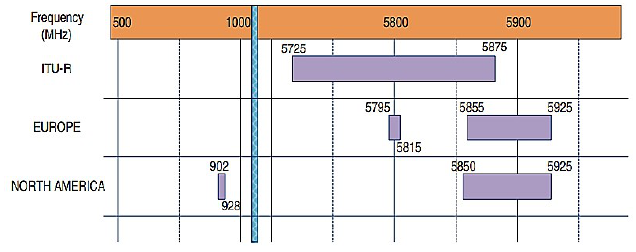
Fig. 9. Spectral range for ITS applications